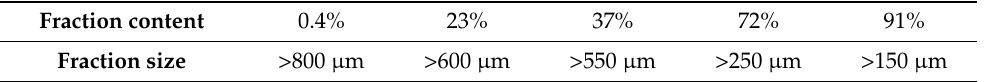
Table 2. Particle size distribution of the synthetic graphite (sieving analysis). Fraction content